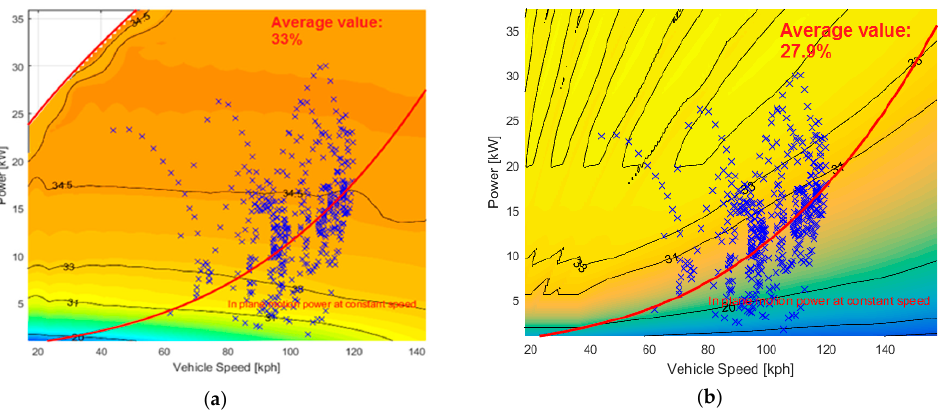
Figure 19. Highway mission work points: ( a ) CVT ; and ( b ) DVT .